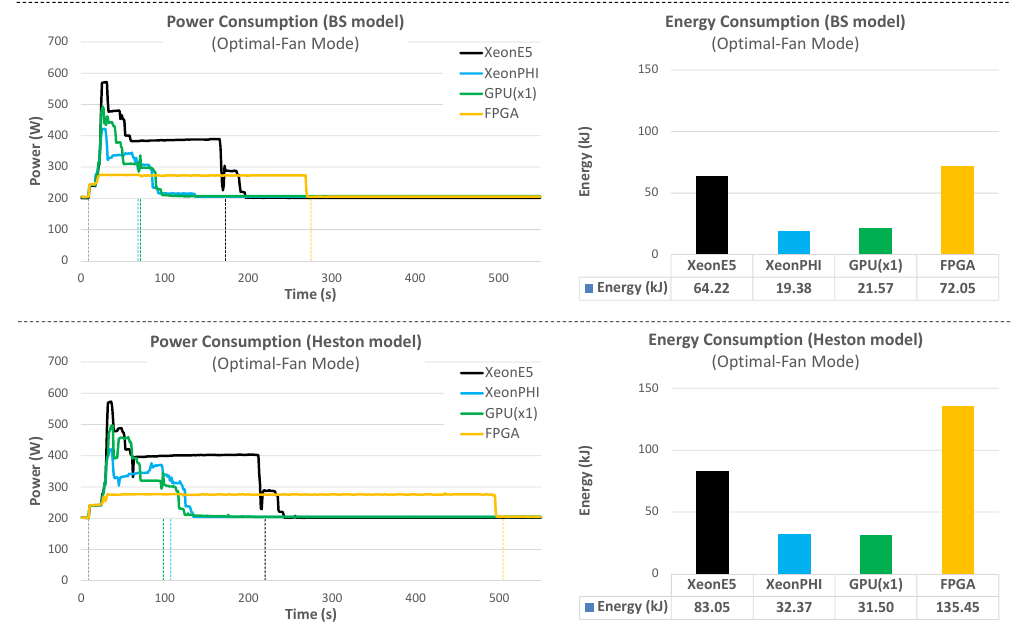
Figure 12. Power and Energy consumption of the complete VaR/cVaR project at system-level. Setup: 32k/32k (see Section 3.1), optimal-fan mode. Only one GPU device in the Nvidia K80 card is used.